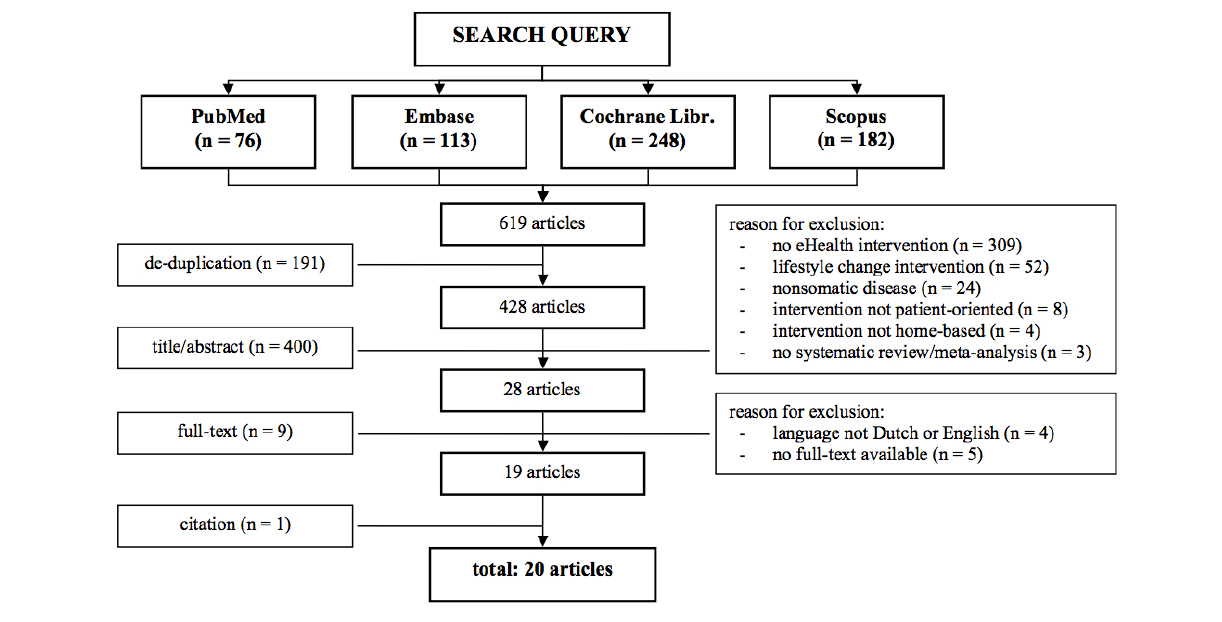
Figure 2. Flow diagram of the literature search on the cost-effectiveness of eHealth